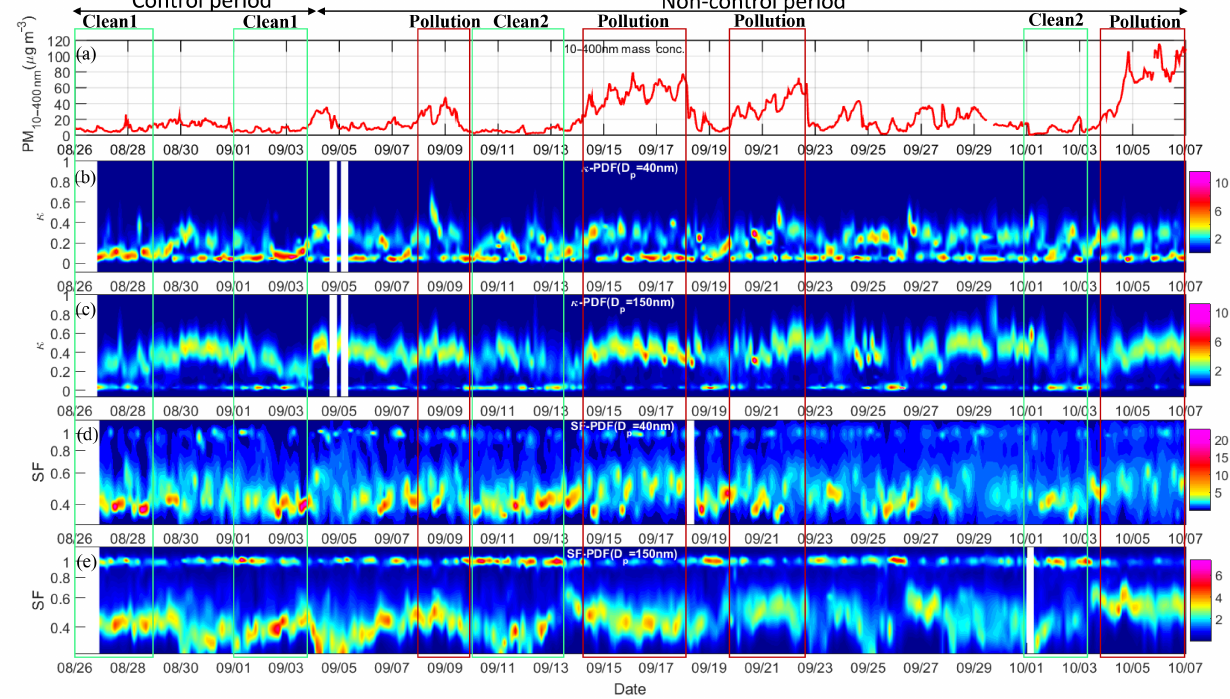
Figure 3. Time series of (a) 10–400nm aerosol mass concentration (PM 10 − 400nm ; assuming that the aerosol density is 1.6gcm − 3 ) , hy- groscopicity parameter κ distributions ( κ -PDF) for (b) 40nm and (c) 150nm particles at RH = 90%, and volatile shrink factor distributions (SF-PDF) for (d) 40nm and (e) 150nm particles at T = 300 ◦